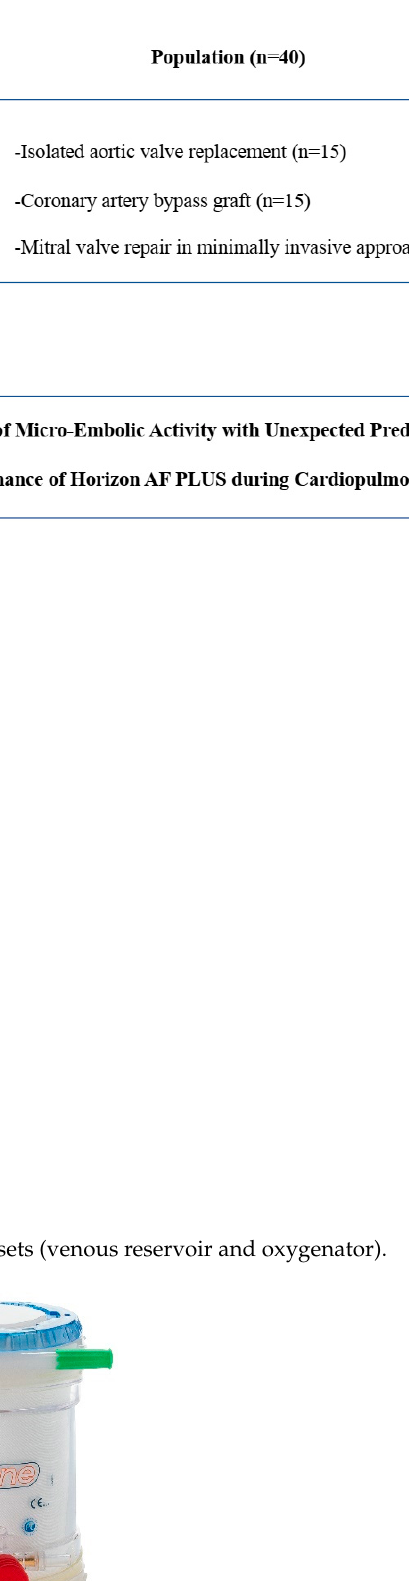
Figure 4. Probes GAMPT BC300 positioning for micro-embolic activity evaluation on Horizon AF PLUS.